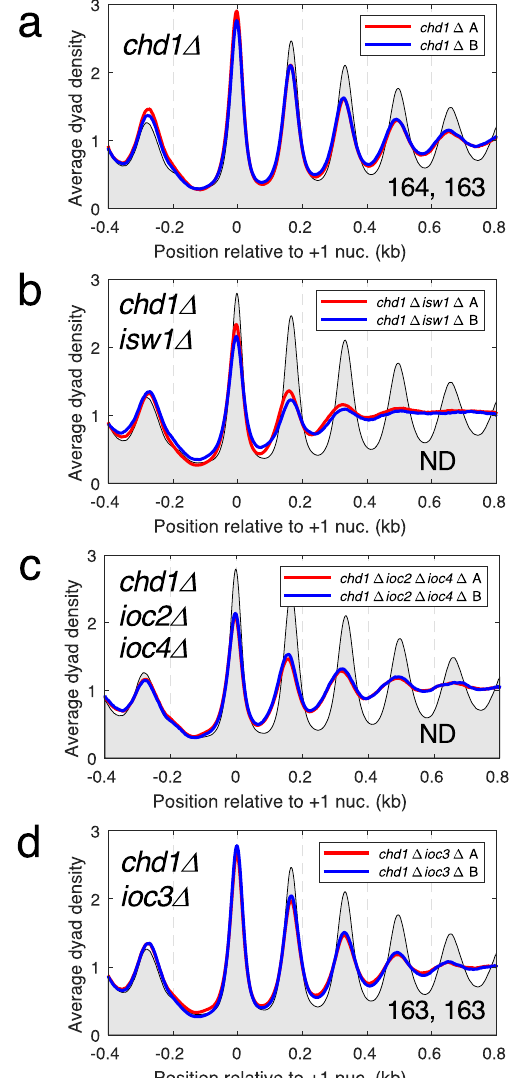
Figure 2. ISW1b and Chd1 are the major remodelers required for normal chromatin organisation. Average nucleosome dyad density plots for all genes: ( a ) chd1∆ , ( b ) chd1∆ isw1∆ , ( c ) chd1∆ ioc2∆ ioc4∆ , ( d ) chd1∆ ioc3∆ . All yeast genes were aligned on the midpoints of their + 1 nucleosomes. The dyad distribution was normalized to the global average (set at 1). For ease of comparison, wild type replicate A is shown as a black line with grey fill in all plots. Two biological replicate experiments (A and B) are shown for each strain in all of the plots (A: red line; B: blue line). The average spacing in bp is shown for replicates A and B in the bottom right corner (measured by regression analysis of the first 5 nucleosome peaks, beginning with the + 1 nucleosome); ND = not determined because the phasing is too weak for accurate